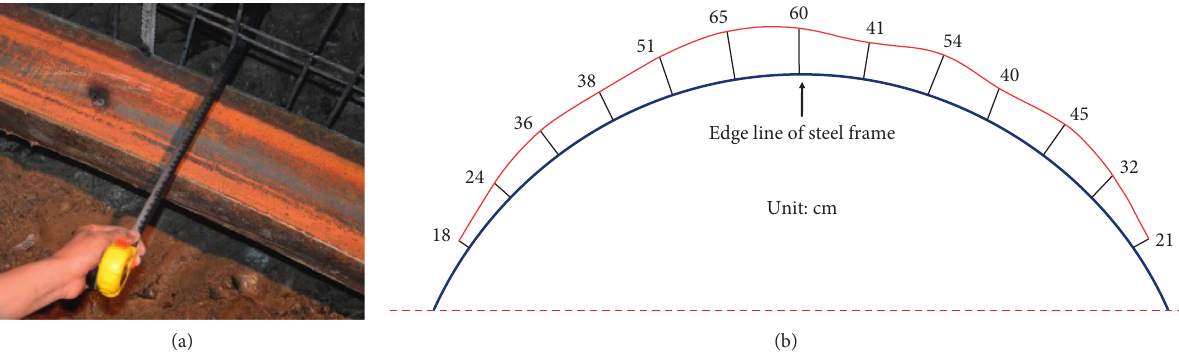
Figure 7: Measurements of step overexcavation on section ZK4357 +801 of left line. (a) Overexcavation measurement of vault edge (65 cm). (b) Overexcavation sketch at the